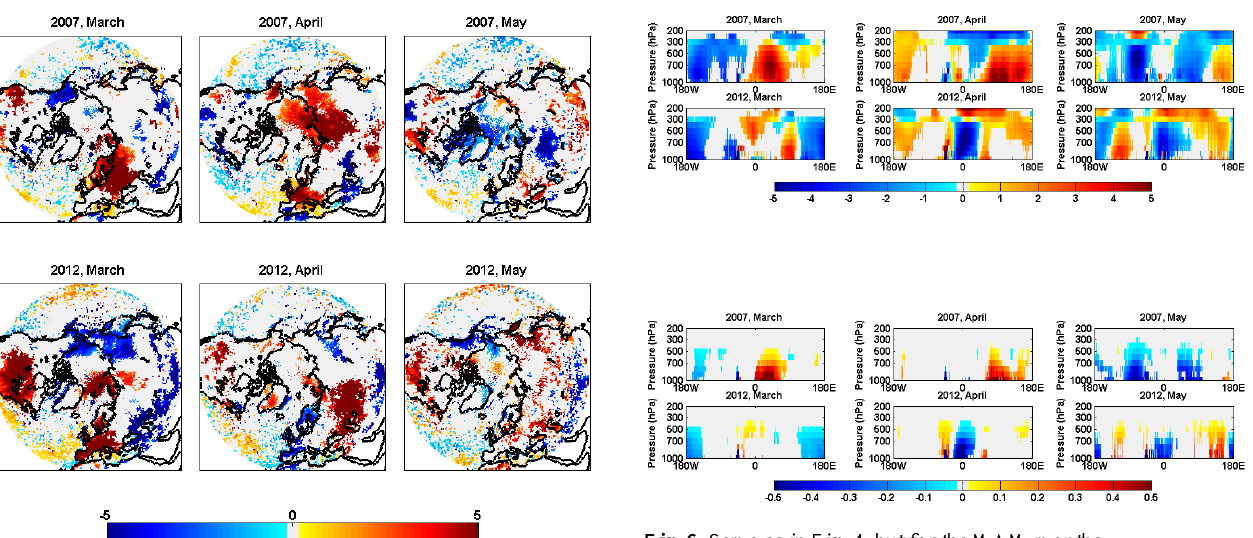
Fig. 6. Same as in Fig. 4, but for the MAM Fig. 6: Same as in Fig. 4, but for the MAM months.